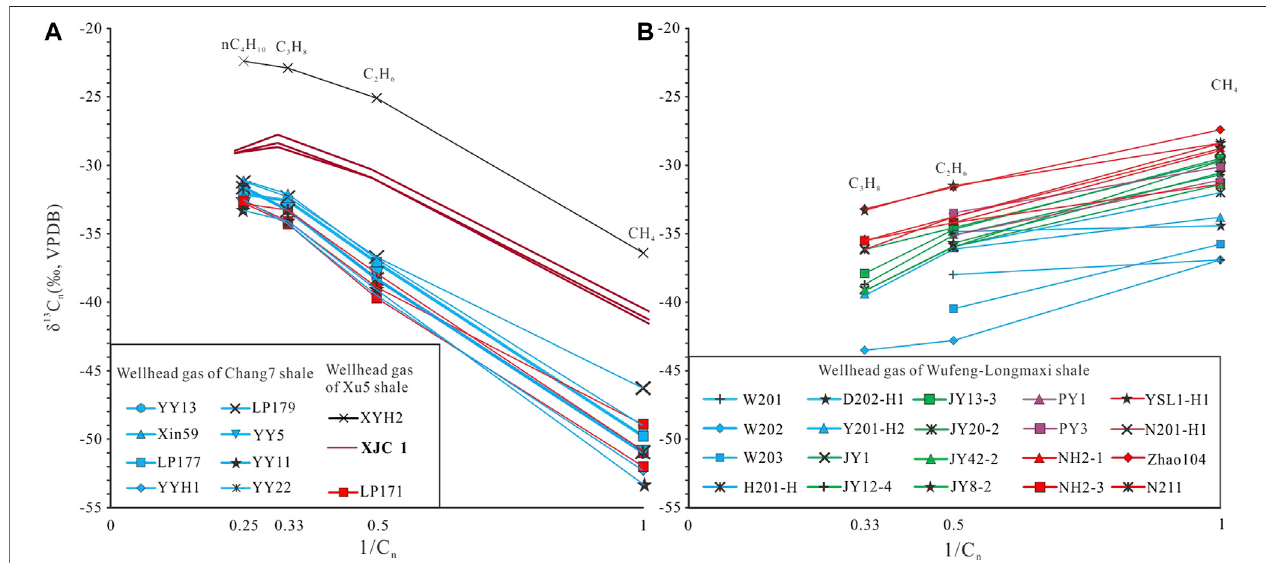
FIGURE 9 | Comparison of carbon isotope series types of alkanes in Chang 7, Xu 5 (A) and Wufeng-Longmaxi Formation (B) (modi fi ed after Dai et al., 2016).